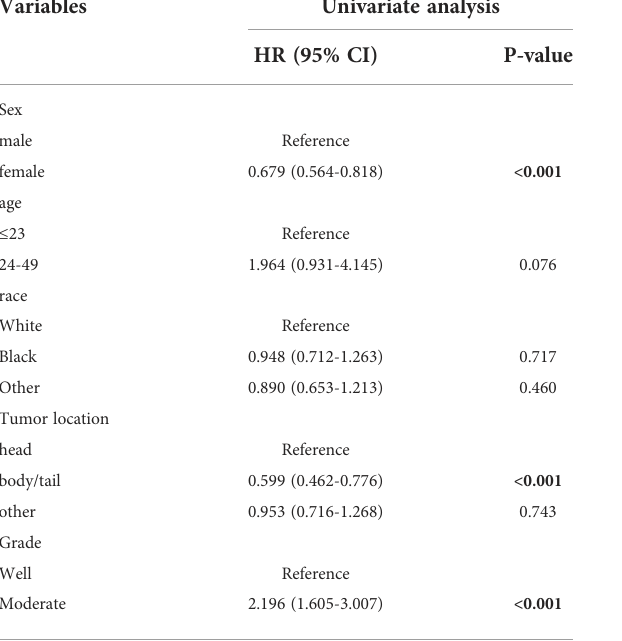
TABLE 2 Univariate analysis of prognostic factors associated with cancer-speci fi c survival for EOPC patients in the training cohort.